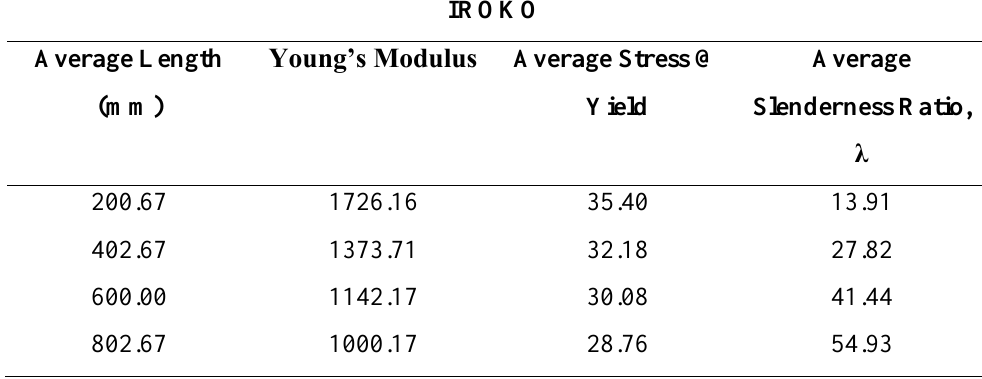
Young’s Modulus, Stress@Yield, Slenderness Ratio